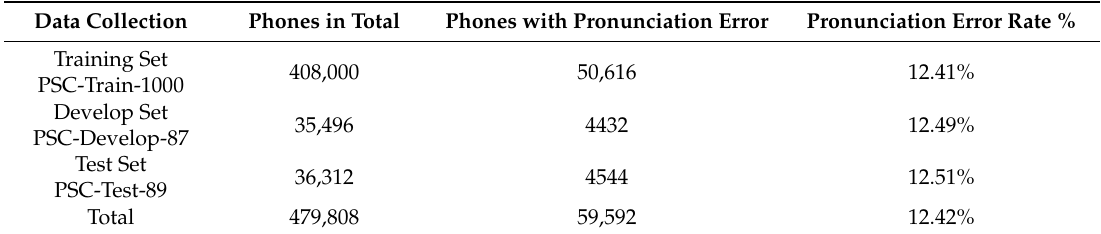
Table 3. Phone tokens for correct and incorrect pronunciations on di ff erent datasets.